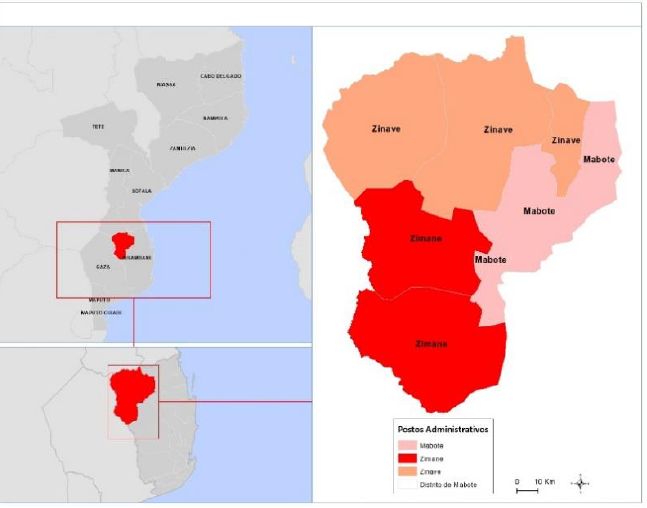
Figure 1. District of Mabote, Inhambane Province.